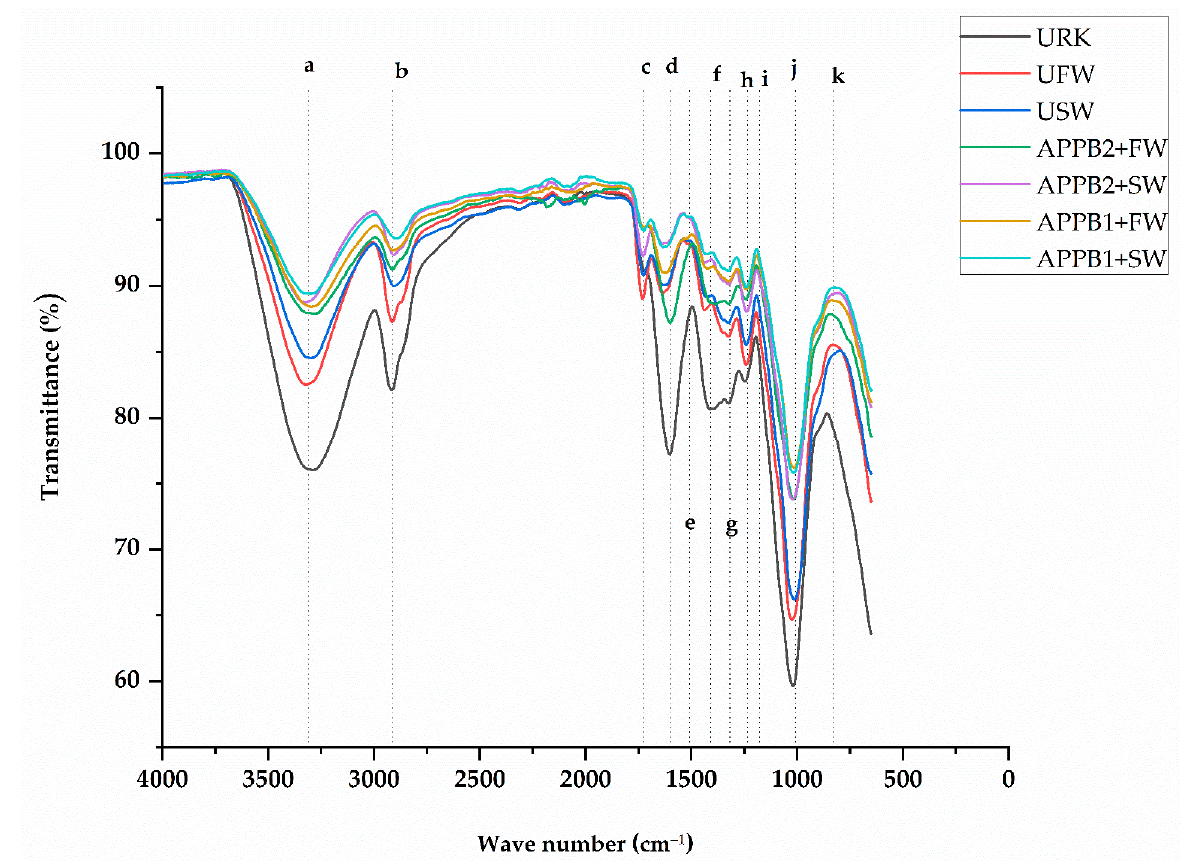
Figure 9. FTIR spectra retted kenaf fibers compared with the unretted raw kenaf bast fibers. The retted fibers recaptured from the six-day retting treatments in combination with APPB and retting solvents.